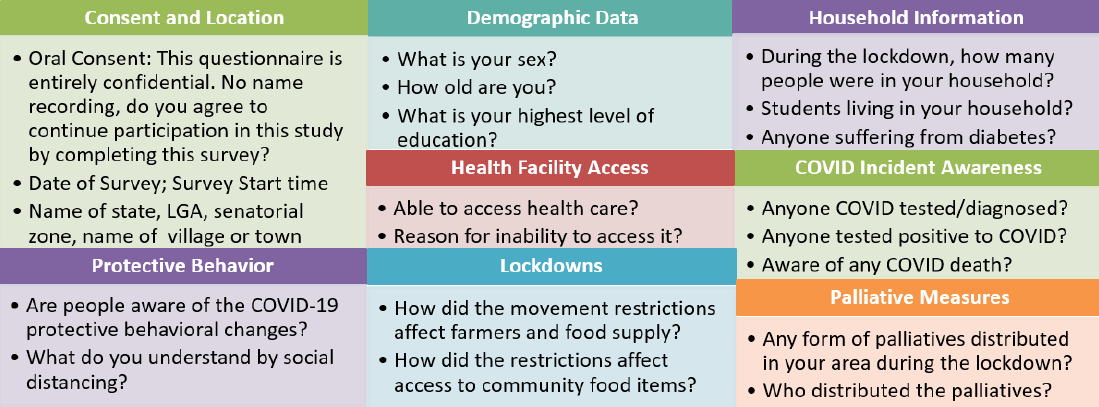
Figure 3. Some of the prompts in the data collection